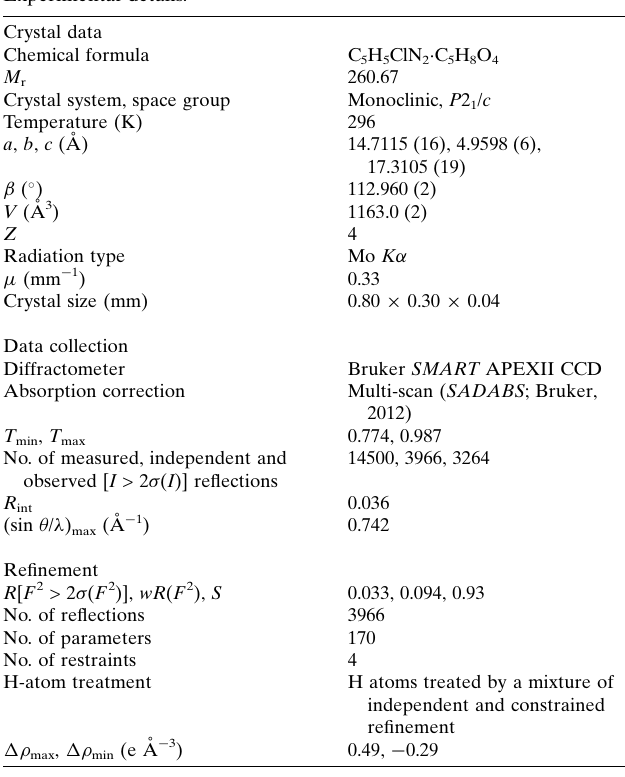
Table 2 Experimental details. Crystal data Chemical formula